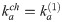
Effect of channeling in systems with constant substrate concentrations.(a) Channeling diagram showing the regions in which channeling accelerates/decelerates enzyme-catalyzed tandem reactions in steady state. These regions are separated by lines calculated for different degrees of diffusion control of the first reaction in the tandem, γ1. The degree of diffusion control of the enzyme complex is denoted by γch. In general, the degree of diffusion control is γ = ka/kD, where ka is the intrinsic (microscopic) association rate constant and kD is the rate due to diffusion. Then the microscopic dissociation rate constant is kd = d(1 + γ), where d is the total dissociation constant; similarly, the microscopic association constant is ka = a(1 + γ), where a is the total association constant. γ, a and d can all be different for channeled and non-channeled reactions (i.e.
a1 ≠ ach
etc.), but we have assumed that the microscopic rate constants are equal, i.e.
kach=ka(1) and kdch=kd(1). [S]max denotes the substrate concentration above which channeling decelerates the tandem reaction independently of the value of γch. The inset shows how [S]max depends on γ1. (b) Product formation velocity, vP, for the non-channeled reaction and for two channeled reactions with different γch/γ1, shown by symbols in (a). In all plots, the intrinsic association and dissociation rate constants are ka(i)=kach=0.027 nM−1 s−1 and kd(i)=kdch=1.35 s−1, where i = 1,2. The enzyme’s turnover numbers are ki=kich=1.5 s−1. These rate constants correspond to the first two reactions in the MAPK pathway [42]. The rate of channeling is kch = 1 s−1 (see Eq (2)).